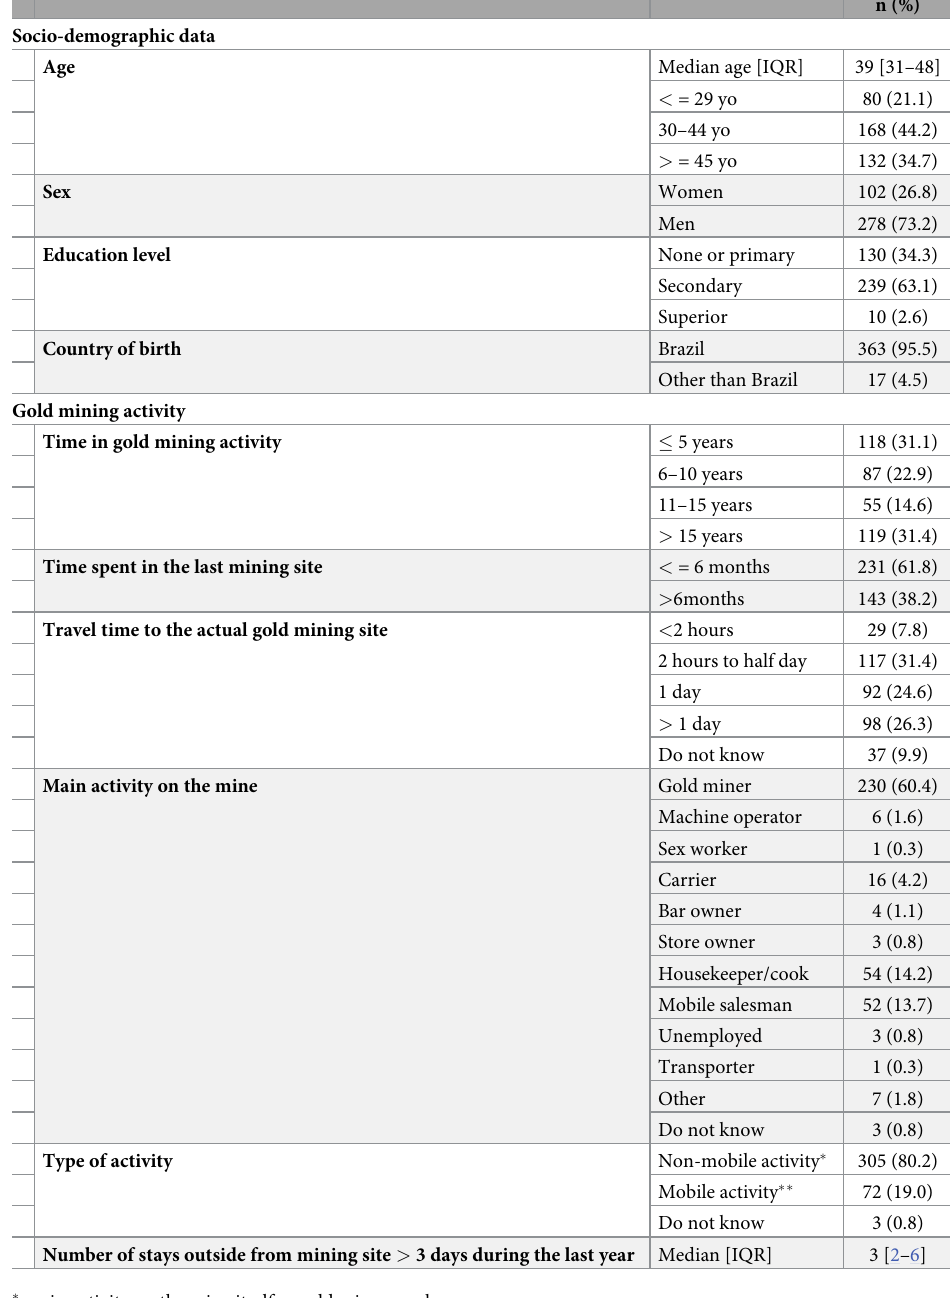
Table 2. Characteristic of the study population of 380 clandestine gold miners working in French Guiana,